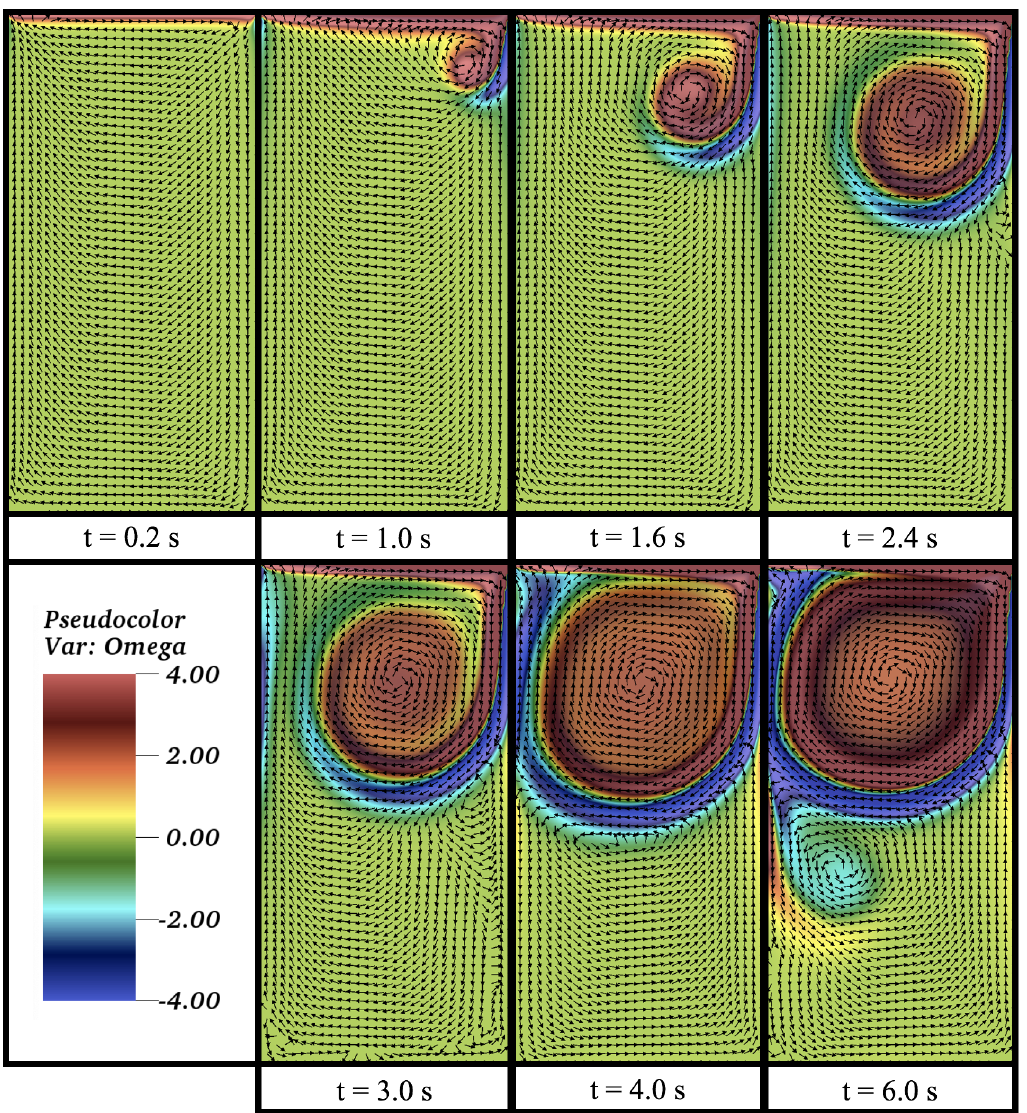
Figure 21. Snapshots showing the evolution of vortical flow patterns during a simulation with Re = 4000. The background colormap is of vorticity and the velocity vector field is also given. Finally, one can change the Re by varying the dynamic viscosity, µ to observe how vortex formation changes within the cavity, as well as, how quickly energy gets dissipated in higher viscosity settings. Recall that if µ is changed to 40 or 4 the time-step, dt , was adjusted for as described above. Figure 23 illustrates how vortex formation changes within the cavity for different Re at three different snapshots during the simulations. Moreover, it gives the horizontal velocity vs. cavity depth, as measured across the middle of the cavity. Note that the Re = 4 and Re = 40 data virtually overlaps in the figure, and velocity (and system’s energy) quickly dissipates to zero going further into the